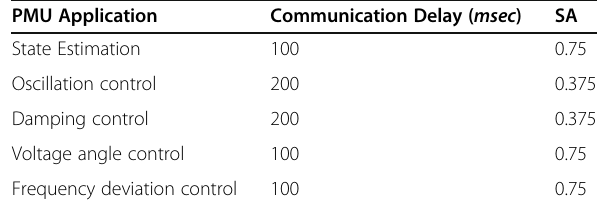
Table 2 Communication delays for various PMU